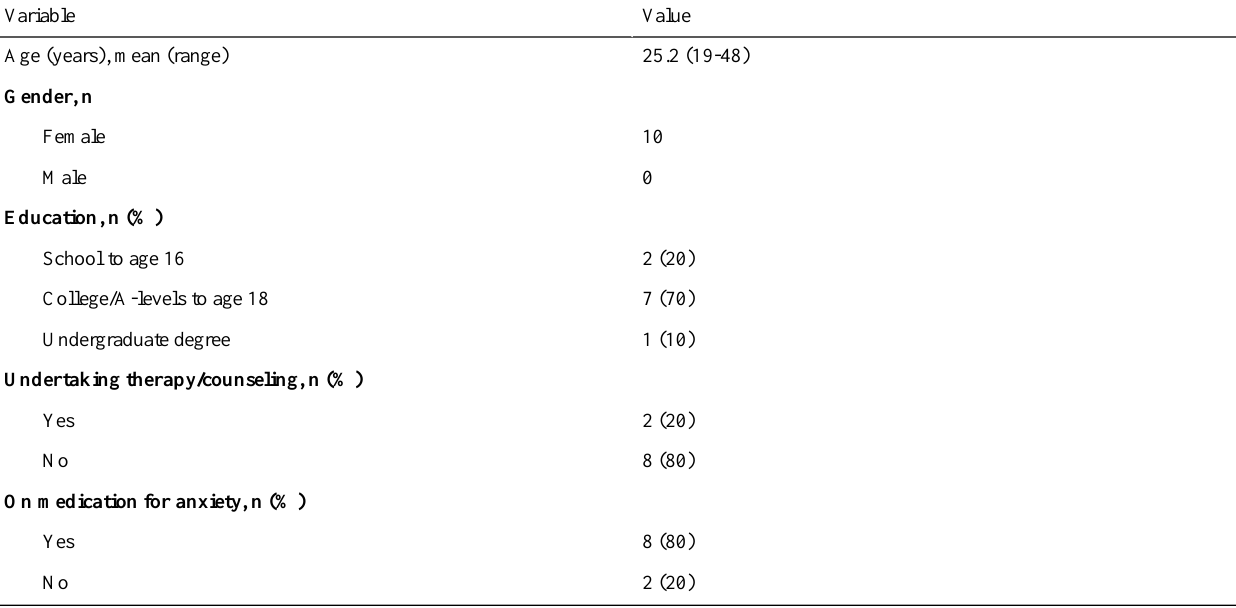
Table 2. Baseline characteristics of the study sample